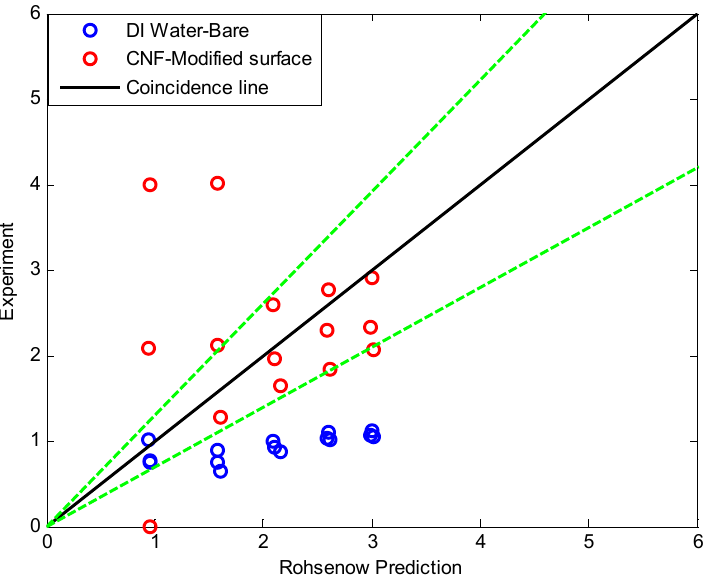
Figure 13. Comparison of boiling heat transfer coefficients.